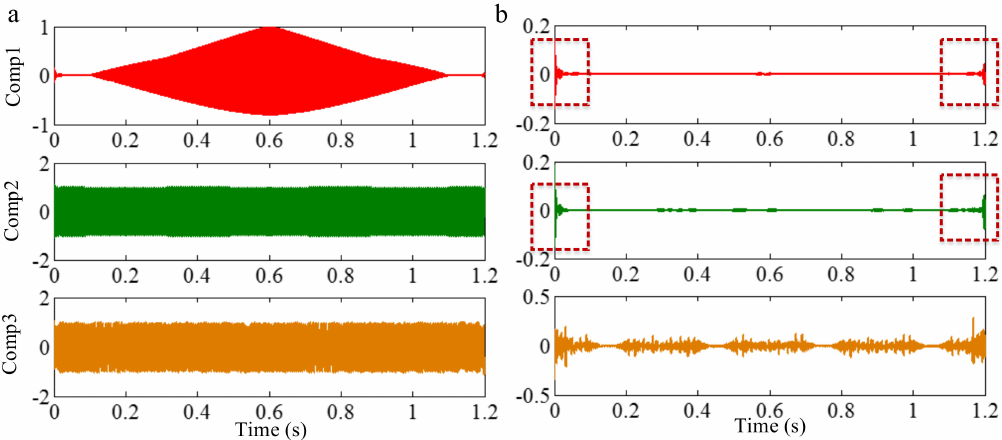
Figure 45. The waveforms of decomposition result of f sig 9 by using VKF_OT and the corresponding calculation errors: ( a ) waveforms and ( b ) calculation